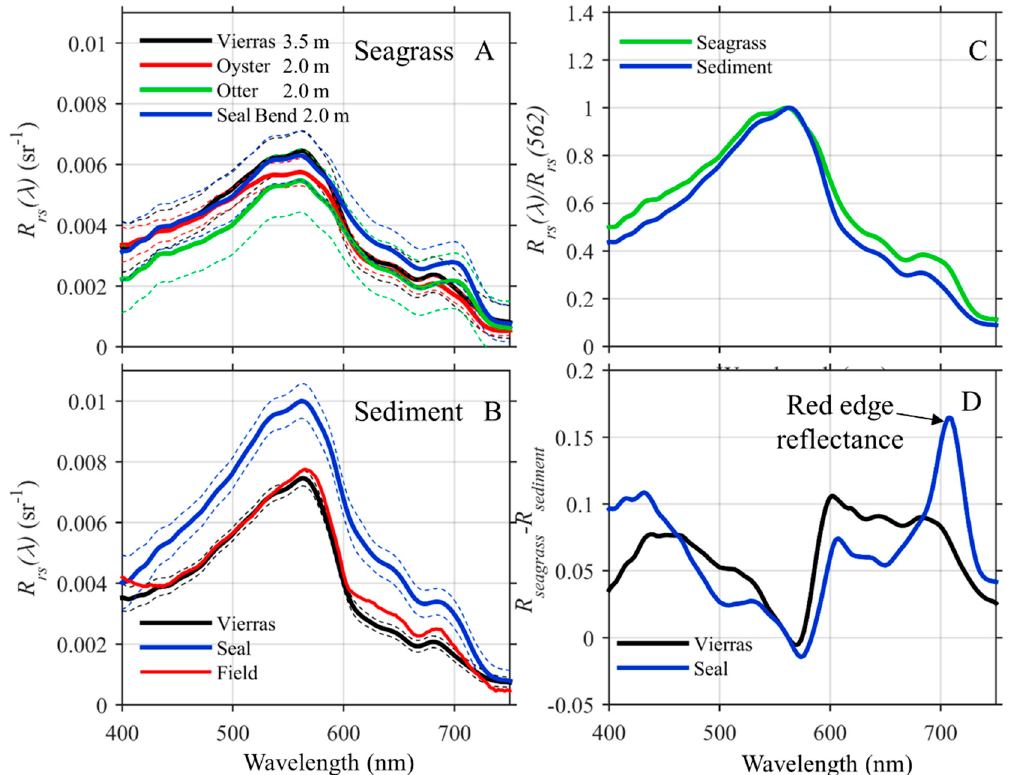
Figure 9. Mean spectral remote sensing reflectance (sr − 1 ) (solid lines) and one standard deviation from the mean (dashed lines) from the PRISM imagery measured overlying seafloor comprised of ( A ) eelgrass beds and ( B ) sediment. Approximate mean bed depths at high slack tide are provided. The field measurement of Rrs conducted over sediment is shown for comparison in panel B. ( C ) The mean PRISM spectra over eelgrass (from panel A) compared to over sediment (panel B) normalized at 550 nm to reveal spectral shape differences. ( D ) The difference between the mean eelgrass and sediment PRISM spectra at Seal Bend and Vierra eelgrass beds reveals similar patterns with the exception of the red edge of reflectance which is evident at the shallower Seal Bend site.